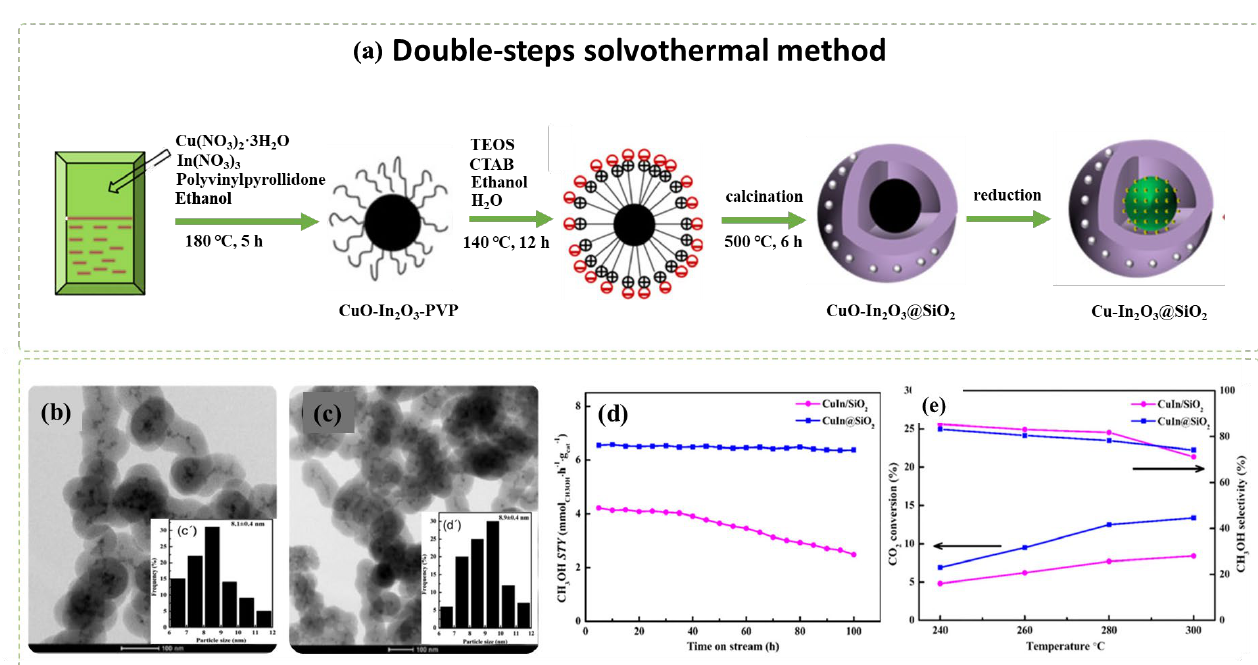
Figure 10. ( a ) CuIn@SiO 2 synthesis by double-step solvothermal methods following its catalytic performance in methanol synthesis: ( b , c ) TEM morphological images of formed CuIn@SiO 2 and reduced CuIn@SiO 2 , respectively; ( d ) space-time yield of MeOH over the catalyst under time-on- stream of 100 h; ( e ) CO 2 conversion rates and product selectivity between conventional CuIn/SiO 2 with CuIn@SiO 2 core-shell catalysts. Reproduced with permission from the work of Shi et al. [57], A novel Core-shell structured CuIn@SiO 2 catalyst for CO 2 hydrogenation to methanol; copyright from AlChE Journal , John Wiley and Sons, 2018.